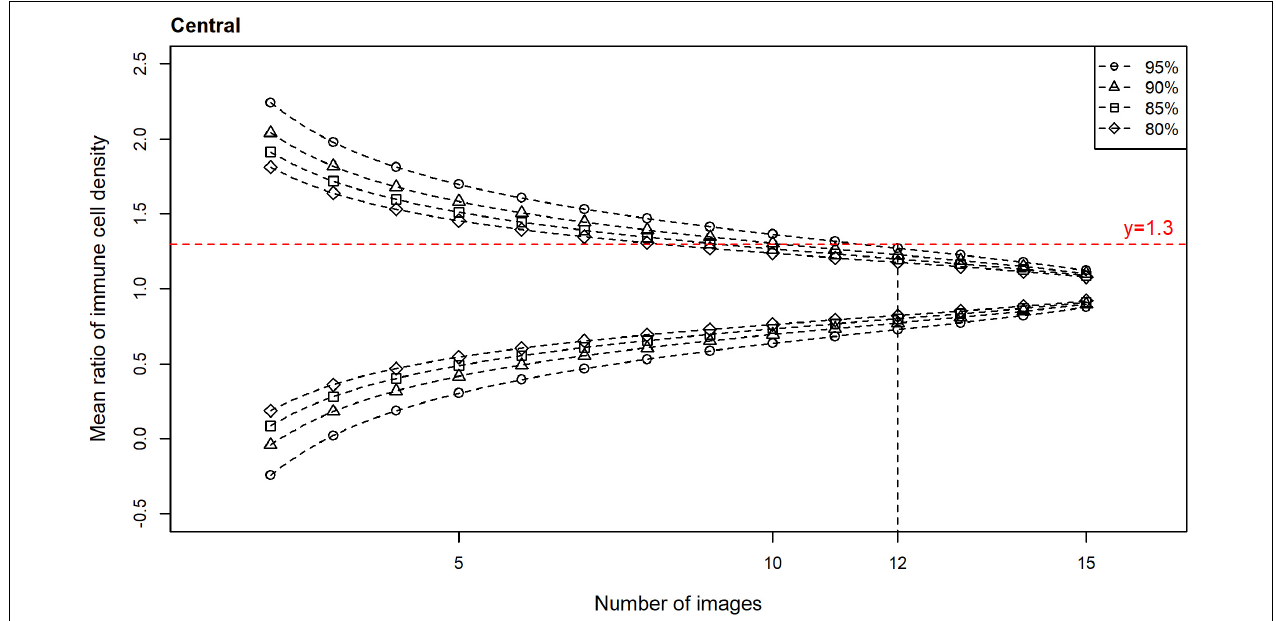
FIGURE 4 | Confidence intervals (CIs) with 80, 85, 90, and 95% levels of confidence for the mean ratio for corneal epithelial immune cell (IC) density relative to the number of randomly selected, non-overlapping images used for the density estimate, for all participants for the central cornea. Horizontal line (mean ratio = 1.3) indicates the location where the estimated mean is 30% different from the true mean in the distributions. Vertical line (number of images = 12) indicates the number of images that is predicted to produce estimated means that are 30% different from the true mean (i.e., mean ratio = 1.3 or 0.7), at a confidence level of 95%, for the central